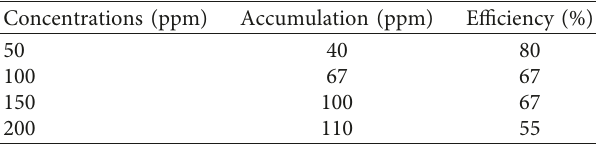
Table 2: Accumulation of Cu 2+ by pomegranate peels.